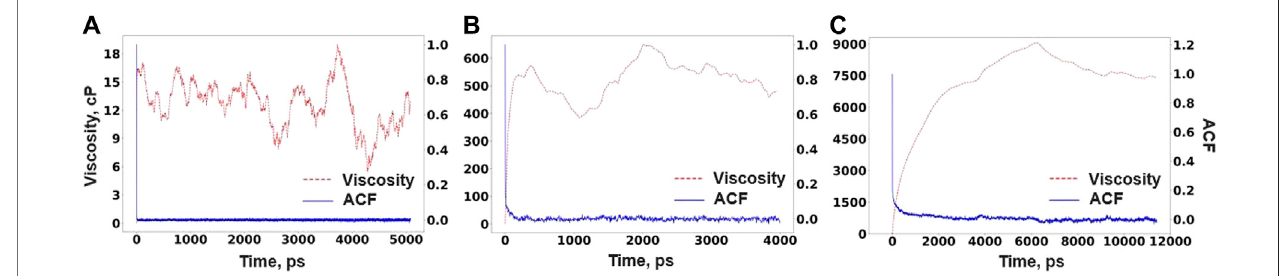
FIGURE 10 | Viscosity and ACF for (A) Composition A at 750 ° C, (B) Composition B at 727 ° C, and (C) Composition C at 700 ° C as obtained from RIM-IPMD calculations.